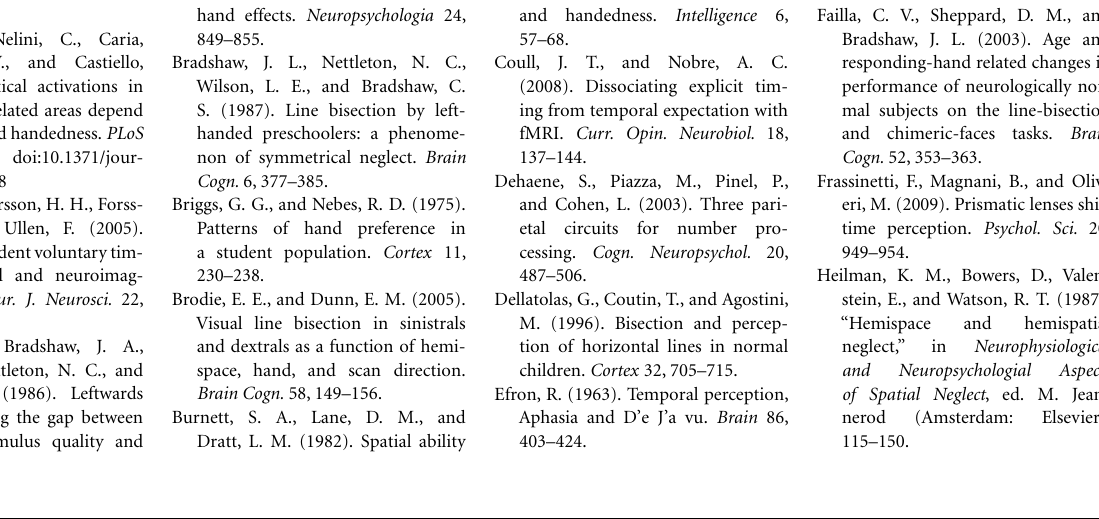
of a pair of lateralized stimuli (brief light flashes and cutaneous shocks were used) was felt when the stimulus delivered to the left visual field or left index finger preceded the stimulus deliv- ered to the right side by 3–4 ms. Instead, the point of subjec- tive simultaneity for a group of left-handers did not differ from